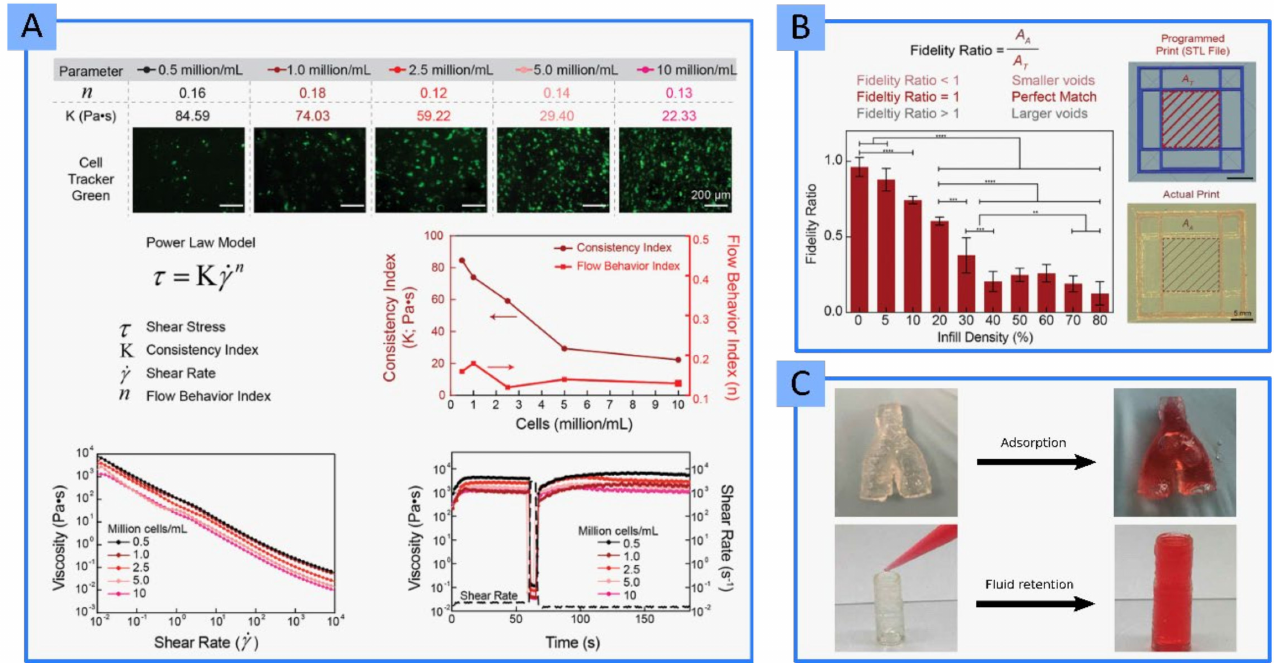
Figure 13. ( A ) Rheological parameters of GelMA/PEGDA/LAP BI loaded with different cellular densities. ( B ) Dependence of fidelity ratio with respect to the infill density (%) of the printed constructs. ** p < 0.05, *** p < 0.005, and **** p < 0.0001. ( C ) Some interesting behaviors of the printed structures after 3DBP and curing. The formulated BI allows obtaining complex 3D free-standing constructs that are able to absorb and retain fluids, something of great utility for vascular designs. Reproduced with permission from [69], Wiley Online Library,